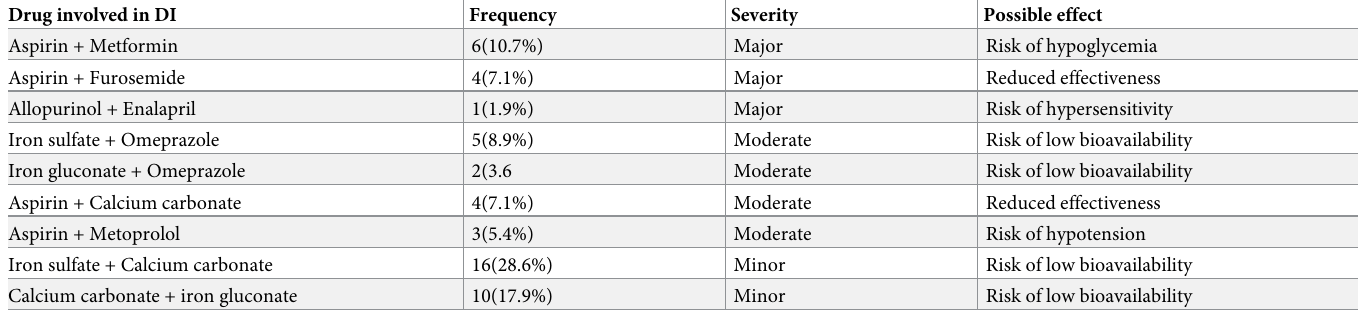
Table 5. Frequency of major drug interaction in CKD patients having follow up at renal clinic of St. Paul’s Hospital Millennium Medical College, Addis Ababa, Ethiopia, June -August, 2019. Drug involved in